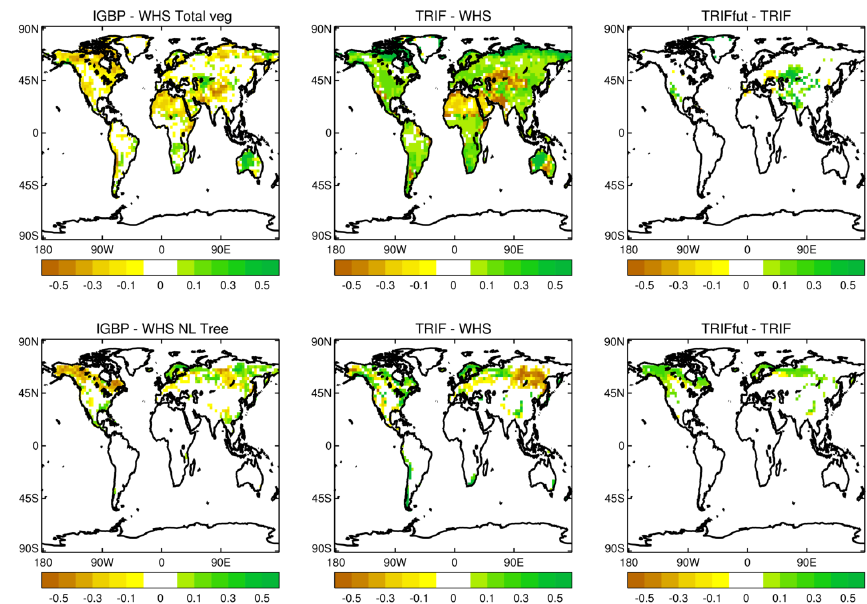
Fig. 1. Difference in vegetation cover (as a fraction of each model grid cell) compared to WHS of (left panel) IGBP and (middle) TRIF and between (right panel) TRIFfut and TRIF. The upper row represents the difference in total vegetation, and the lower row to (NL) needleleaf